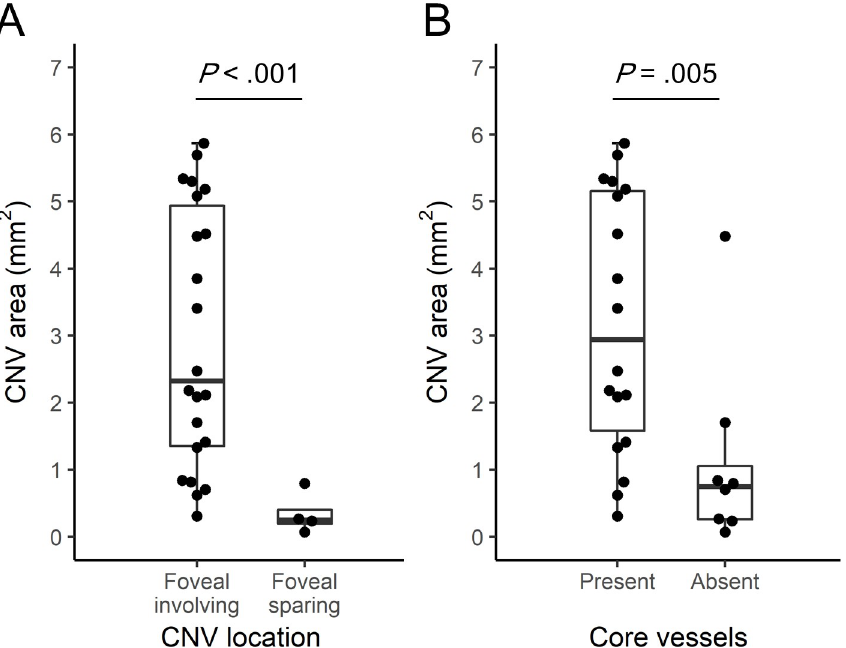
Fig 3. The area of choroidal neovascularization (CNV) on en face OCT angiography by CNV location and the presence of core vessels in all study eyes. A, A boxplot showing the area of CNV based on the CNV location. Each dot represents one eye. B, A boxplot showing the area of CNV based on the presence of core vessels.